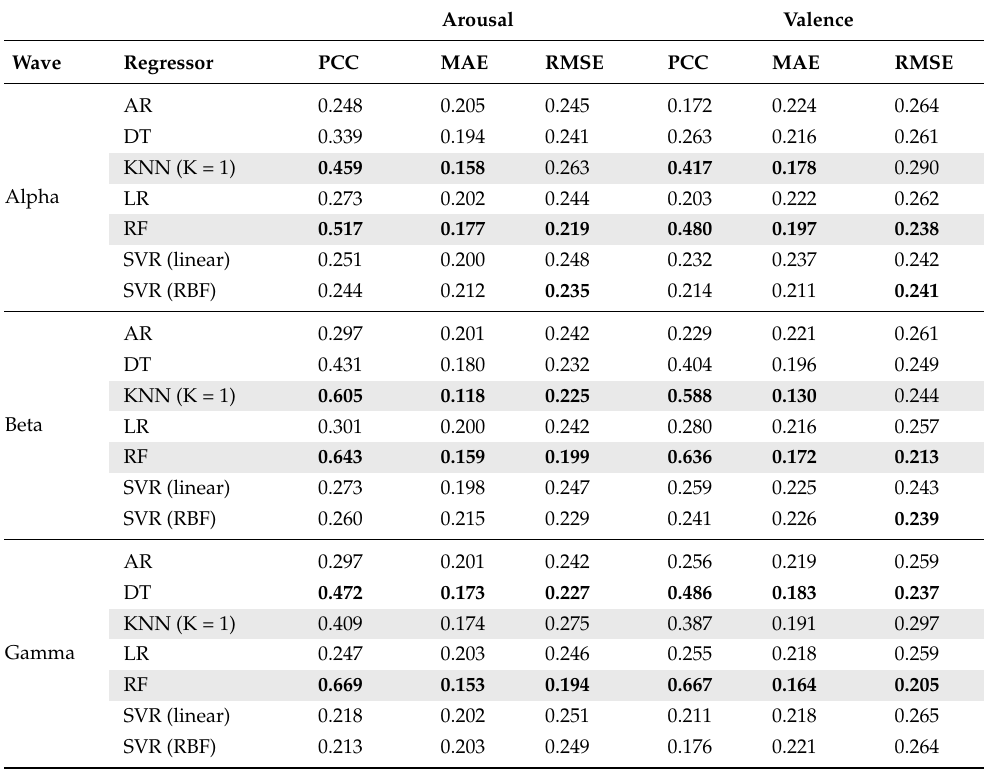
Table 3. Results for each regressor per wave. Values in bold represent the two best results for each column in each wave. Grey rows represent the selected